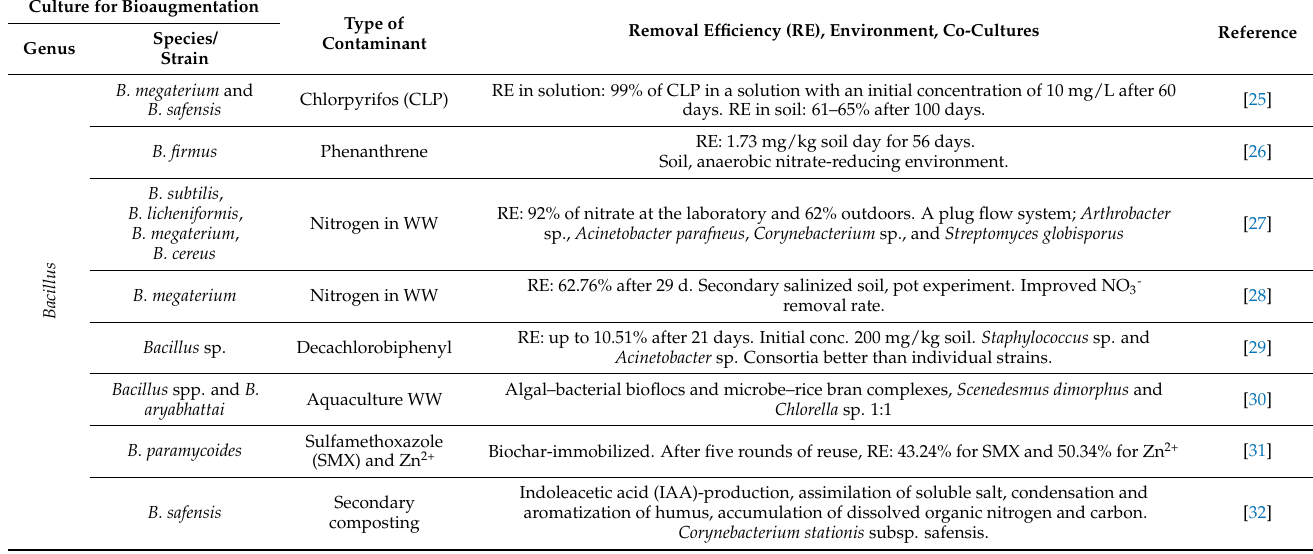
Table 1. Studies on biodegradation with the application of Bacillus spp., Pseudomonas spp., and Rhodococcus spp. as bioaugmentation